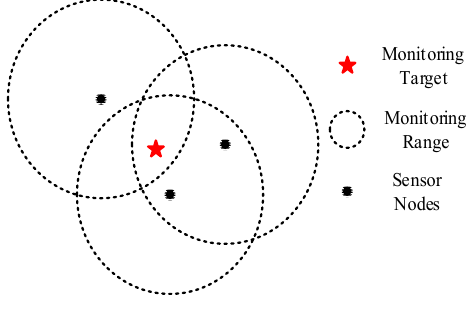
Figure 2. Threefold coverage.